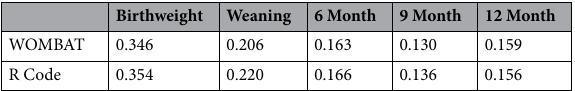
Table 2. Comparison of heritability values with Wombat software.